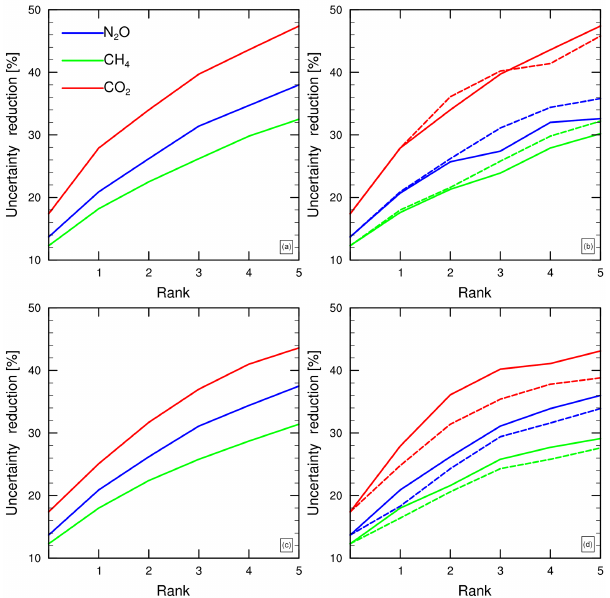
Figure 5. Uncertainty reduction for the five stations added to the base network for (a) each GHG individually, (b) the multi-objective optimisation (solid lines: GWP weights; dashed lines: equal weights (SE1)), (c) the sensitivity test (SE2) with changed observational un- certainties for each GHG individually and (d) the sensitivity test (SE4) with multi-objective optimisation using GWP weights that also includes the distance (solid lines) and SE5 (dashed lines) (red: CO 2 ; green: CH 4 ; and blue: N 2